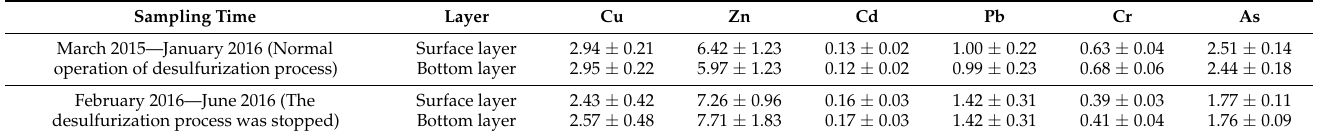
Table 2. The average concentration of heavy metals Zn, Cu, Cd, Pb, Cr and As in seawater ( µ g/L). Sampling Time Layer Cu Zn